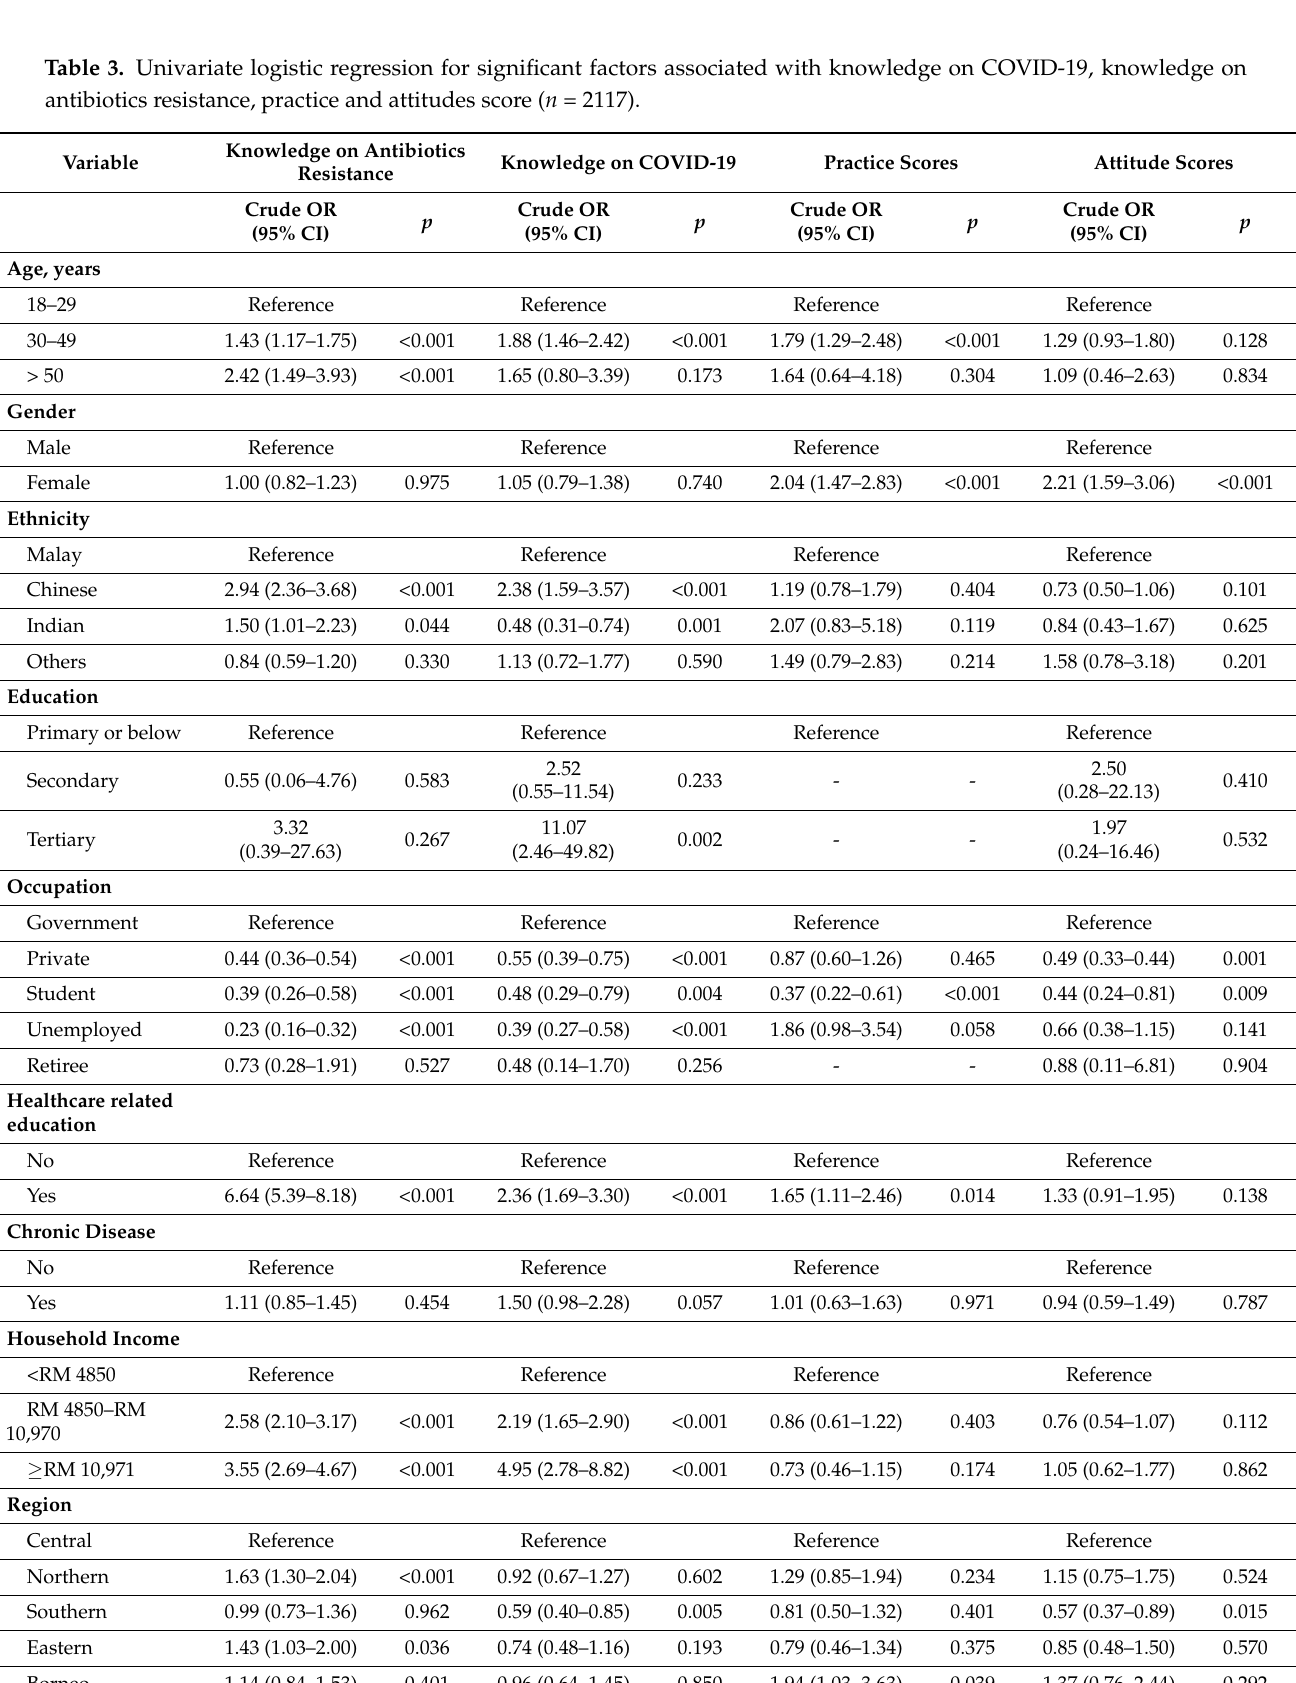
Table 3. Univariate logistic regression for significant factors associated with knowledge on COVID-19, knowledge on antibiotics resistance, practice and attitudes score ( n =